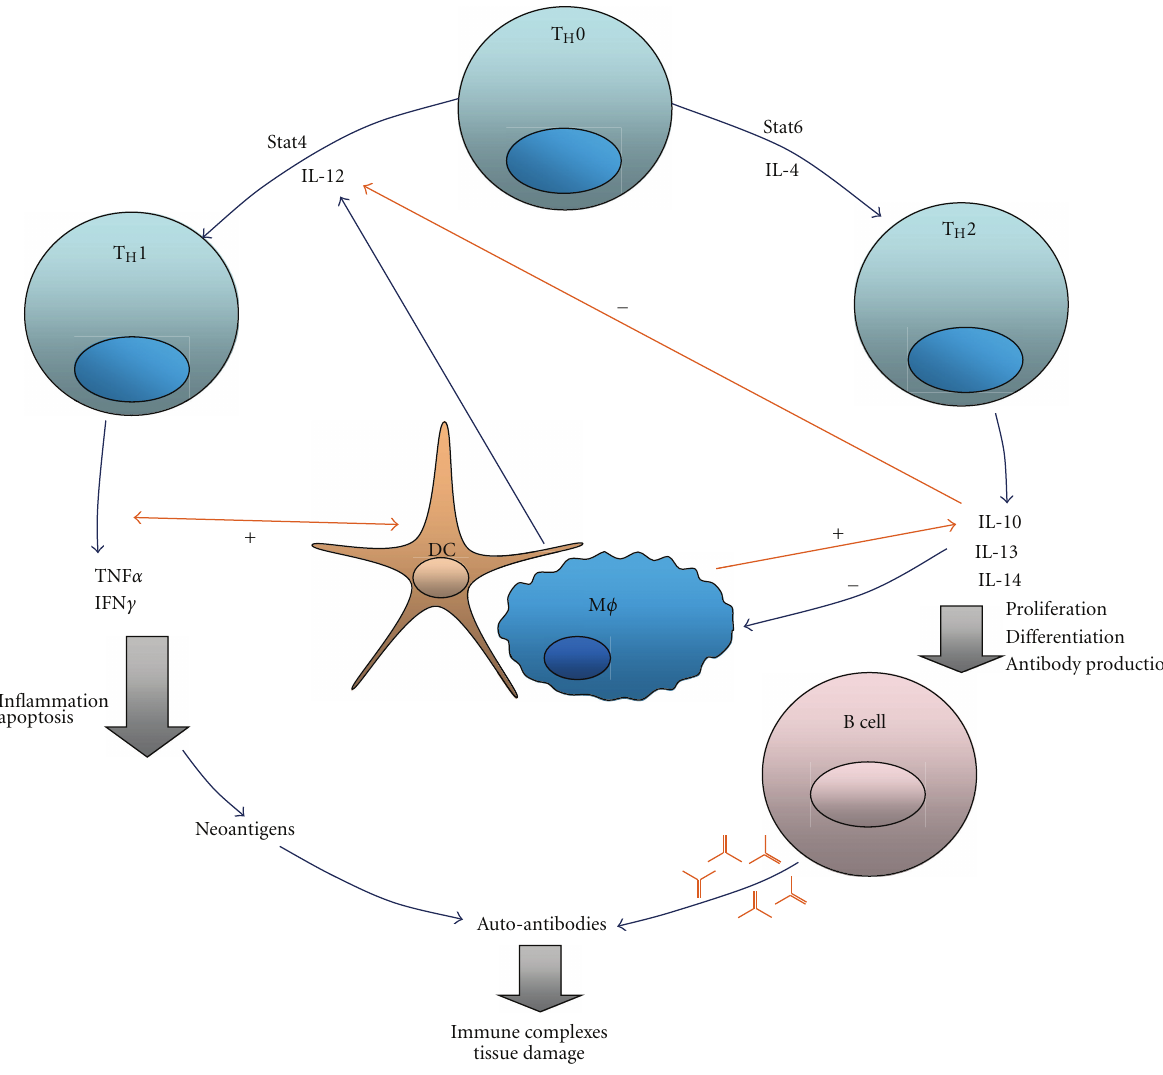
Figure 1: Feedback loops between IL10 and TNF α -simplified model (from L´opez et al. [4]). Th1 cells produce TNF α , which activates dendritic cells, other antigen presenting cells (APCs) and induces IL-10 production. TNF α also promotes inflammation and apoptosis, gen- erating neoantigens that can produce autoantibodies. Conversely, IL-10 antagonizes Th1 di ff erentiation and inhibits APCs and T cells. IL-10 strongly stimulates B-cell proliferation, di ff erentiation, and antibody production. As such, B-cell activation in the presence of neoantigens may cause autoantibodies to be secreted and lead to tissue damage. Stat is a signal transducer and transcription